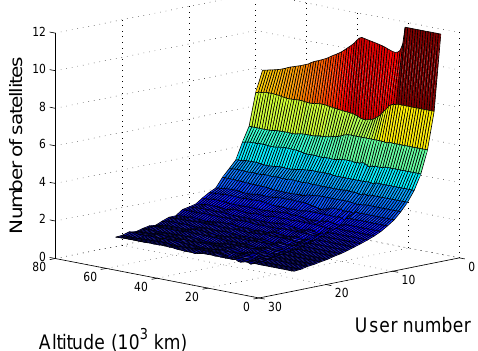
Figure 9. Availability of multiple users (the worst user).